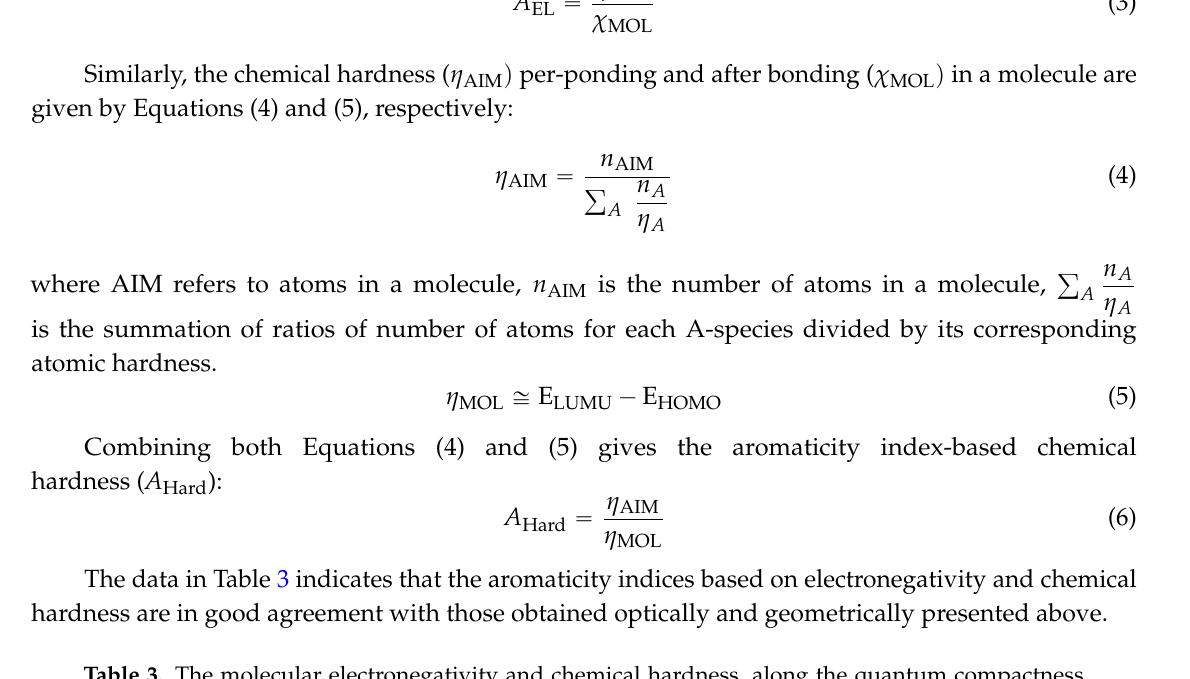
Table 3. The molecular electronegativity and chemical hardness, along the quantum compactness aromaticity A EL and A Hard indices for studied dyes at PBE/6-311++G** level of theory. all energetic values in electronvolts